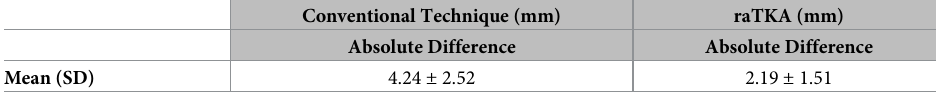
Table 4. Absolute difference values for change in posterior offset between techniques.